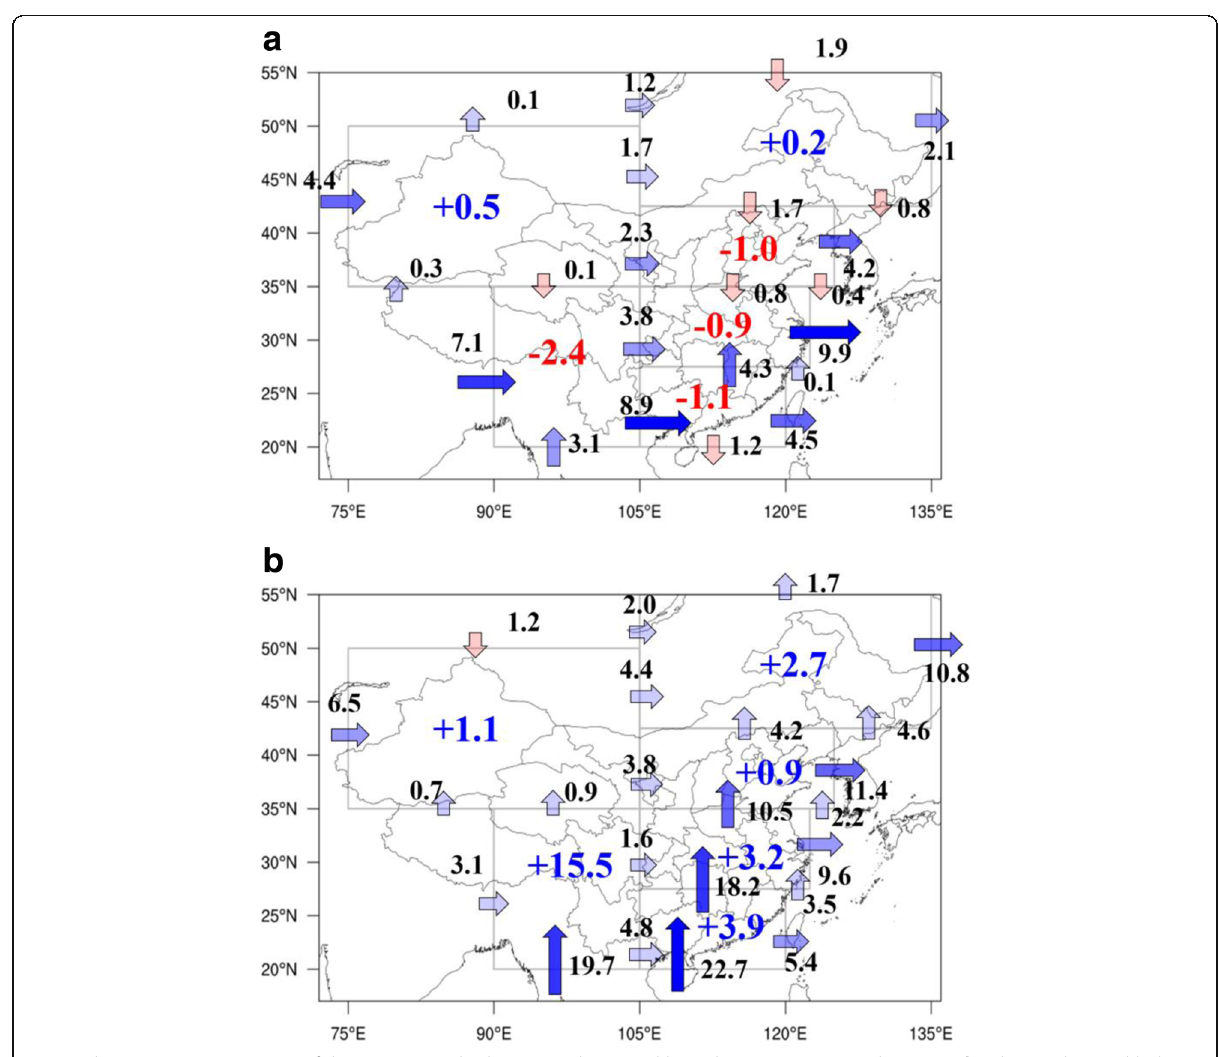
Fig. 5 Climate mean (1961 – 2011) of the water vapor budget via each regional boundary in winter ( a ) and summer ( b ). The numbers in black represent the amount of water vapor (unit 1e8 kg/s) transport via each boundary, and numbers in red ( blue ) represent divergence (convergence) of water vapor in this region. The arrows represent the transport direction of water vapor, the red represents from north to south, and blue represents from west to east or from south to